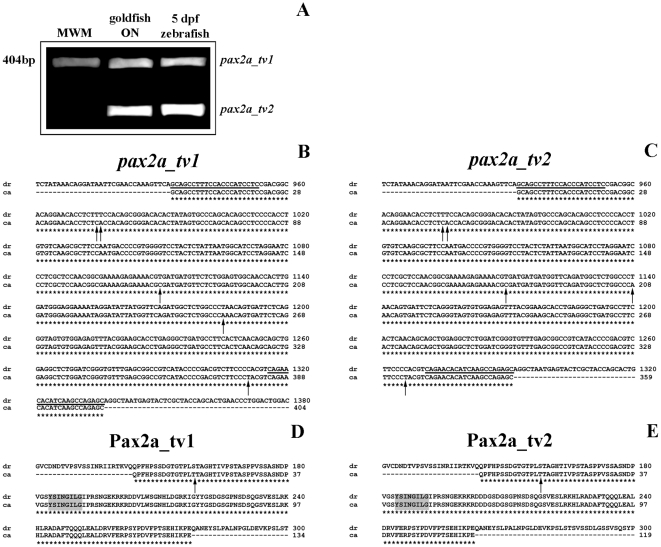
Gene expression and molecular characterization of goldfish pax2a mRNAs.(A) Expression of two pax2a mRNA variants (pax2a_tv1 and pax2a_tv2) in goldfish optic nerve and 5 dpf zebrafish embryos by RT-PCR. MWM: molecular weight marker. (B–C) Comparison of two goldfish partial-length cDNAs, pax2a_tv1 and pax2a_tv2, with their corresponding homologous in zebrafish. Alignment produced with the ClustalW program of the nucleotide sequences of pax2a of both cyprinidae species. The primers used for the molecular characterization are underlined and indicated in Table 2. The differences in the base pairs are shown with an arrow and the similarities with an asterisk. (D–E) Comparison of goldfish Pax2a_tv1/tv2 and their corresponding homologous in zebrafish. Alignment produced with the ClustalW program of the deduced amino acid sequences of Pax2a_tv1/tv2 of both cyprinidae species. The difference in the amino acids is shown with an arrow and the similarities with an asterisk. The octapeptide domain is marked in grey.